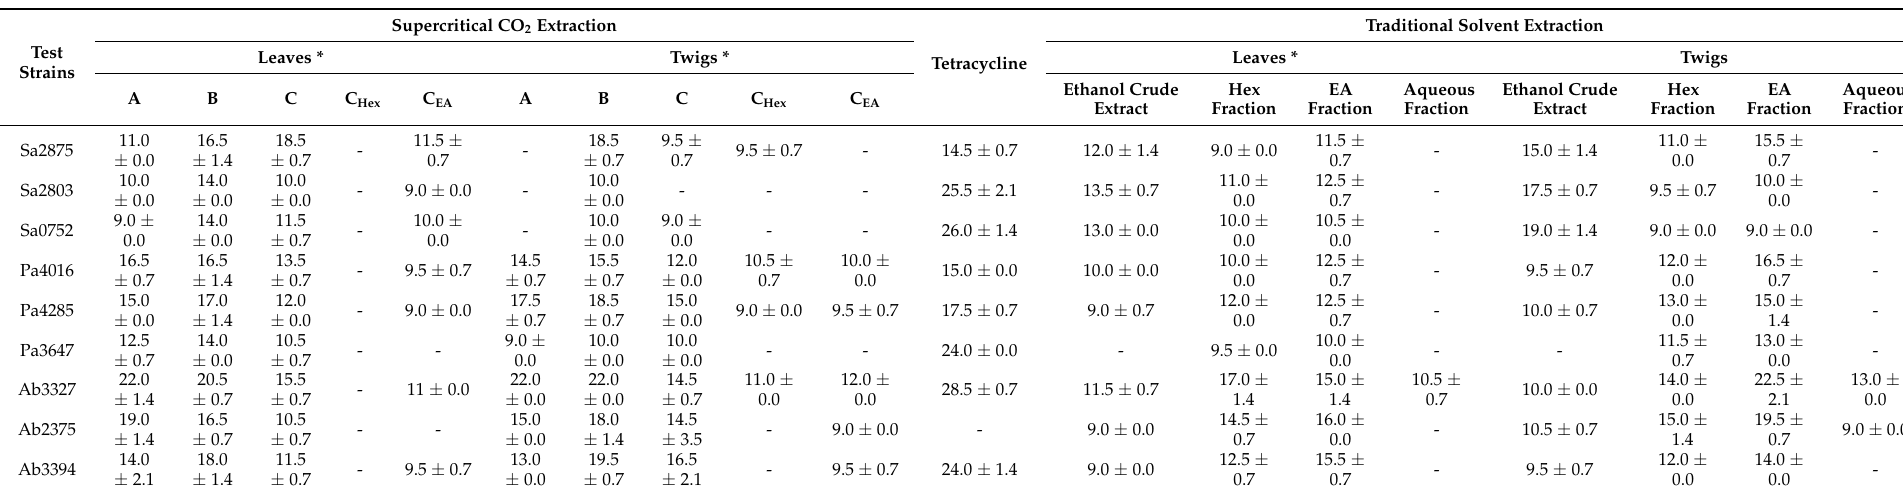
Table 2. Disk Inhibitory zone (mm) of the various extracts.